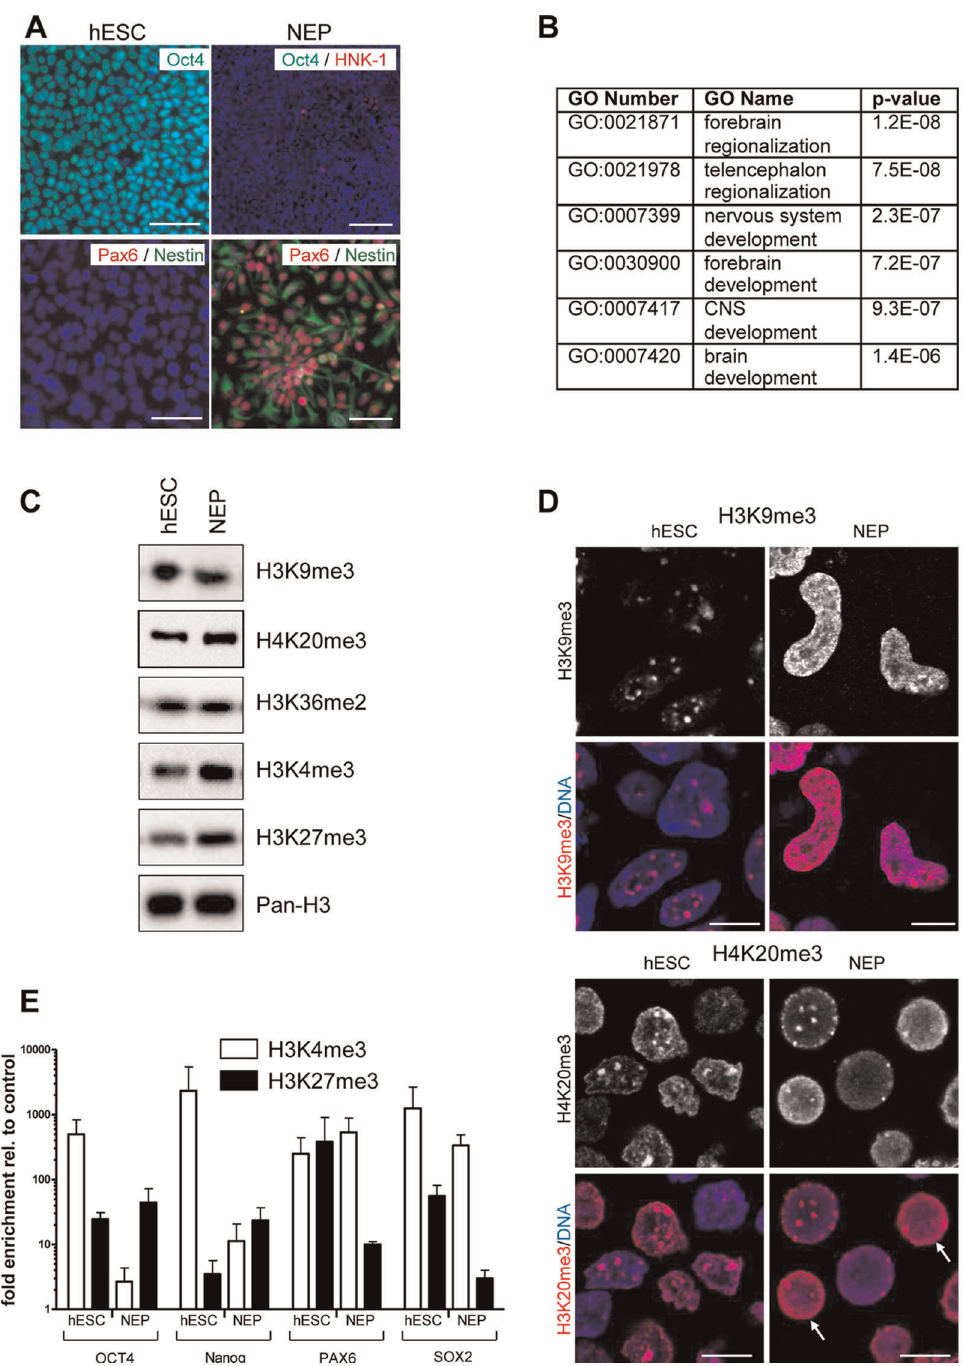
Figure 1. Effect of neuroectodermal differentiation on localization of histone marks. (A) hESC were differentiated towards NEP and stained with antibodies specific for Oct4, HNK-1 (neural crest marker), Pax6 (NEP marker) and nestin (neural stem cell marker). Nuclei were stained with the DNA dye H-33342 (blue). Scale bars: 100 m m. (B) GO analysis of the up-regulated genes in NEP compared to hESC (C) Whole cell extracts from hESC and NEP were analyzed by Western blot with antibodies specific for the indicated histone H3 modifications. Total histone H3 (Pan-H3) was used as loading control. (D) hESC and differentiated NEP were grown on glass cover slips and immunostained with antibodies specific for H3K9me3 or H4K20me3. The upper panels show grey-scale signal intensities of the stain, the lower panels show a superimposition of the same histone stain as above (red) with a DNA counter-stain (DAPI, blue). Arrows mark two cells with a diffuse H4K20me3 stain, which differs from the spot-like pattern always observed in hESC. Scale bars: 10 m m. (E) Chromatin immunoprecipitiation was perfomed from nuclei of hESC or NEP with antibodies specific for H3K4me3 and H3K27me3. The abundance of promoter regions of OCT4, NANOG, PAX6 and SOX2 was measured by qPCR with specific primers for the indicated genes. Data were compared to control samples prepared without specific antibody and are indicated as relative enrichment. Data are means 6 SD from 2 experiments.